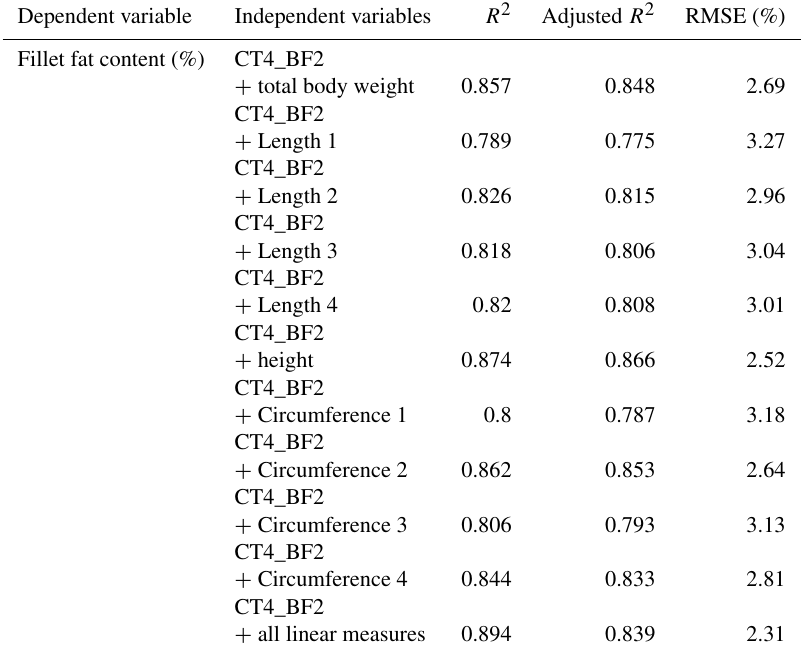
Table 5. Results of multiple linear regression for fillet fat content (%) and CT-based back-fat thickness (cm) with the addition of linear measurement ( n = 33, p < 0 .